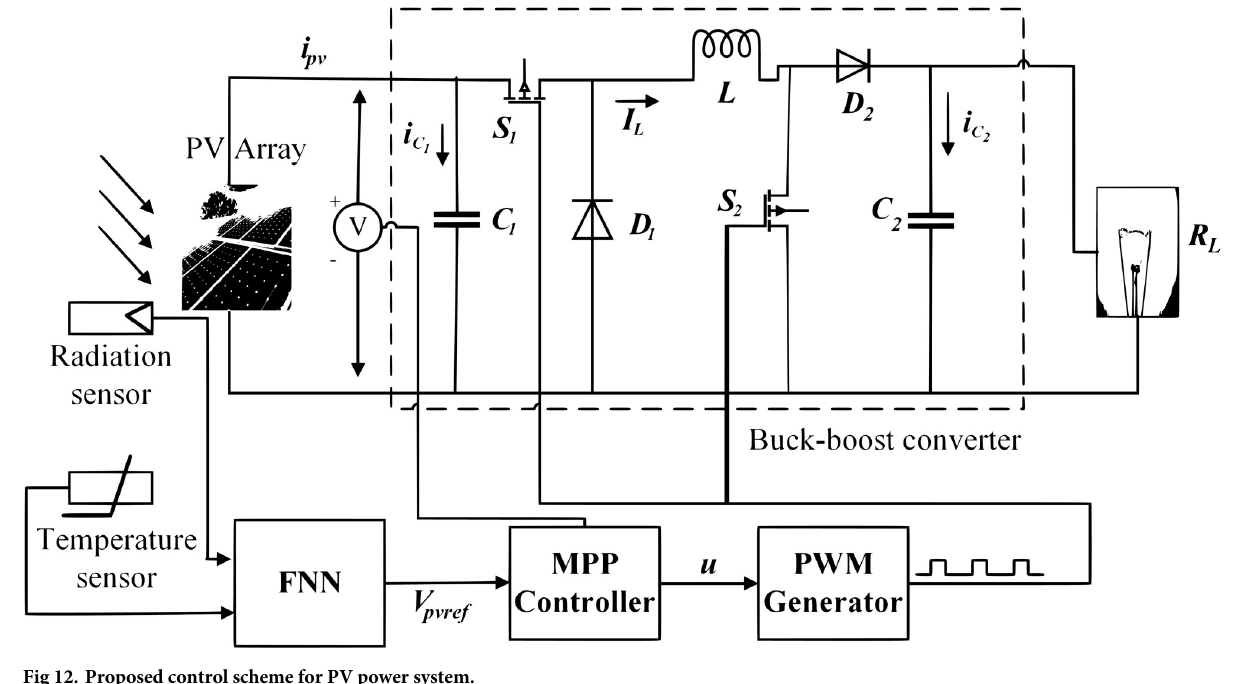
Fig 12. Proposed control scheme for PV power